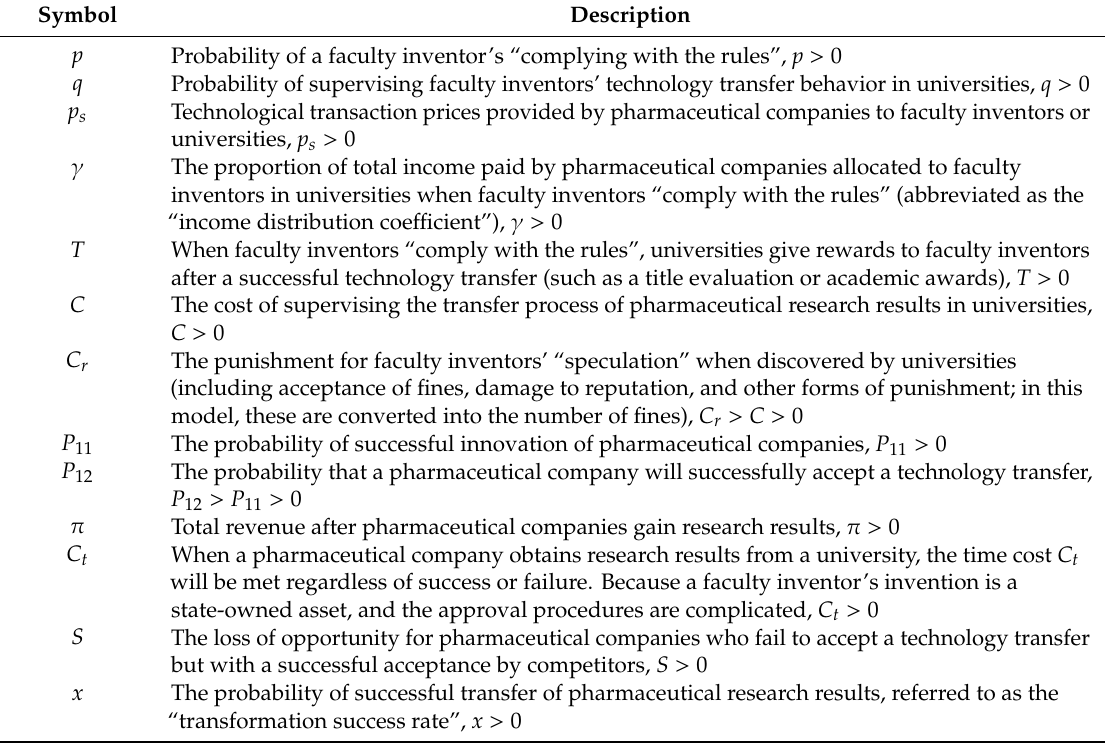
Table 1. Variables in the game